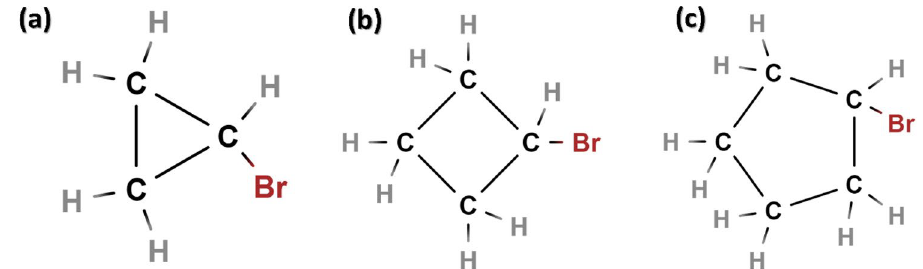
drawn in one plane. The full three-dimensional structure is shown in the Supplementary Information.